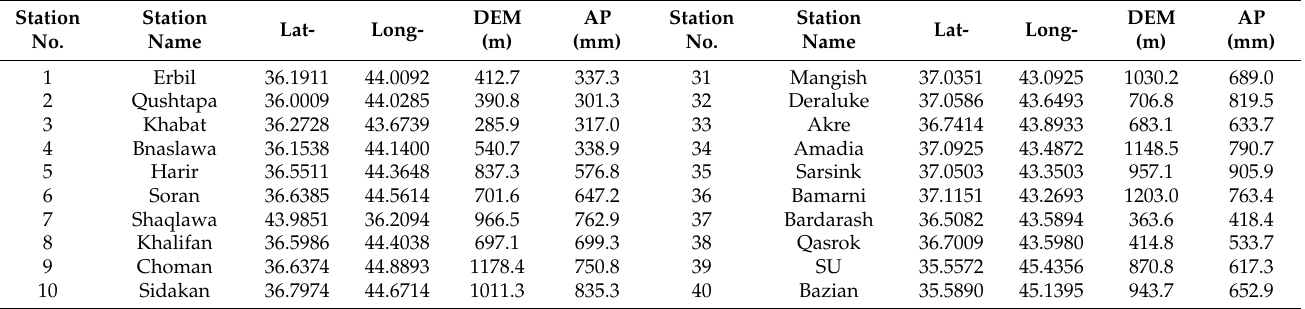
Table A1. The Annual Precipitation (AP) (mm) (average of 24 years), DEM, and coordinates (latitude and longitude) of the 60 meteorological stations in the IKR used in this